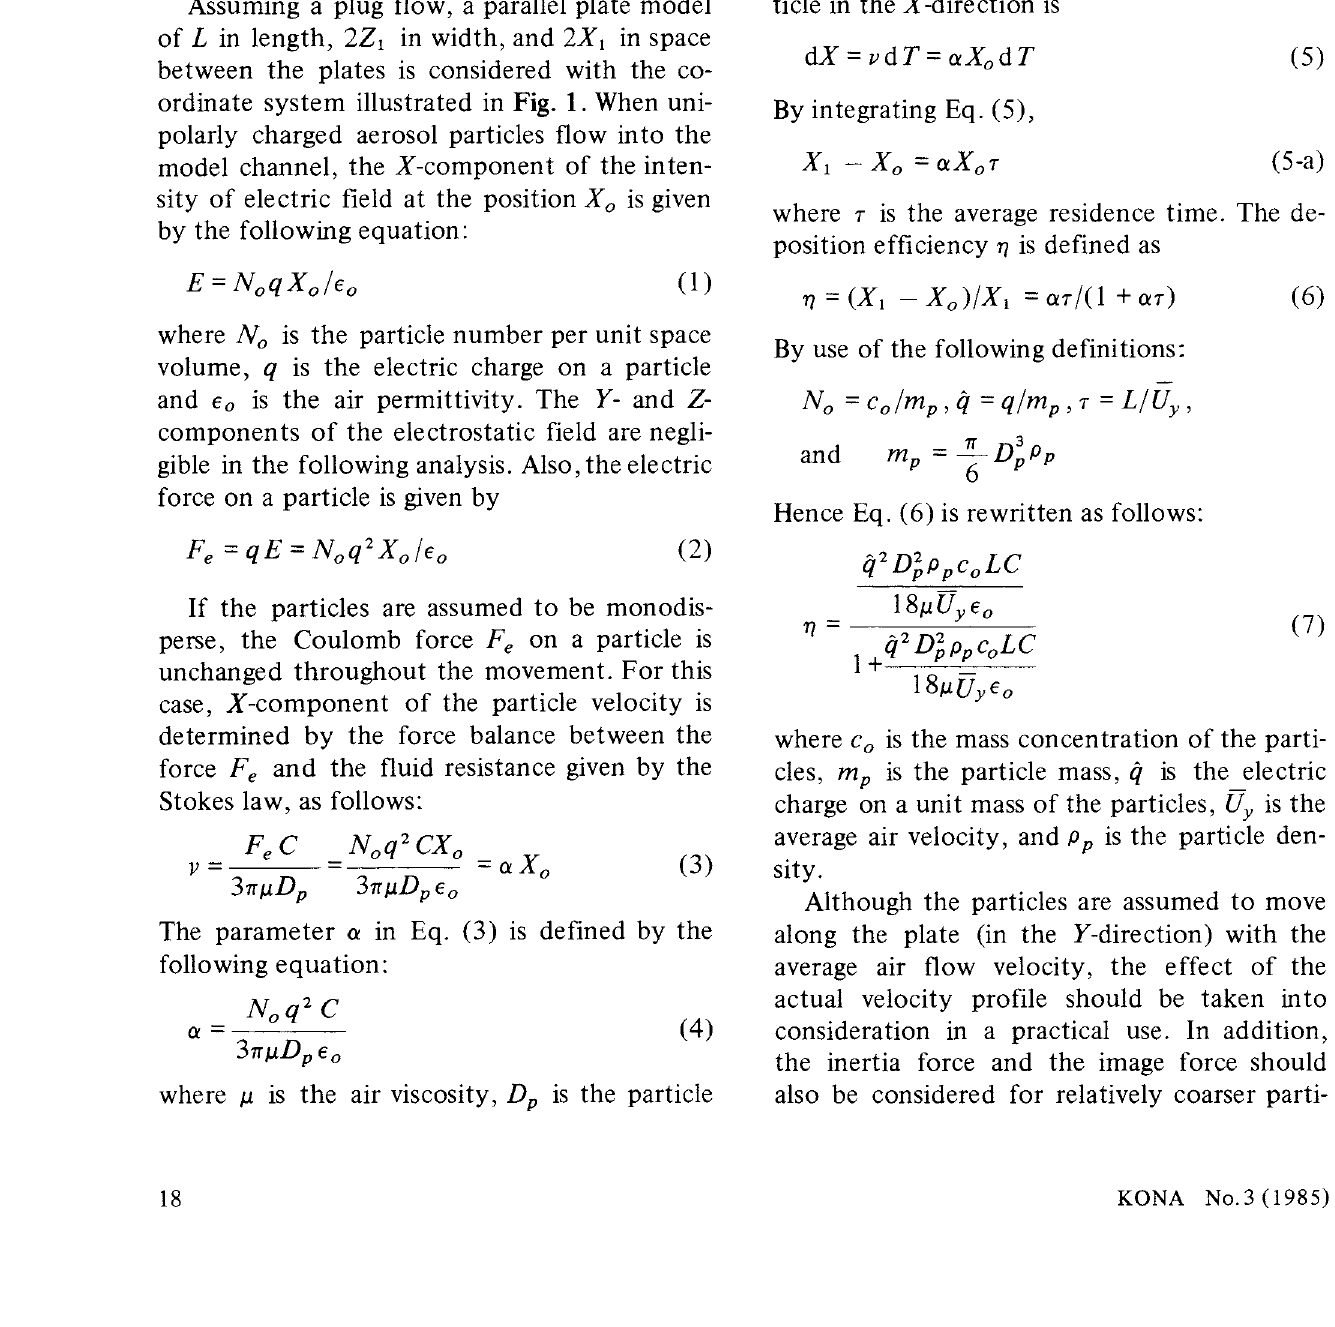
Fig. 1 Adopted coordinates in the calculation of particle